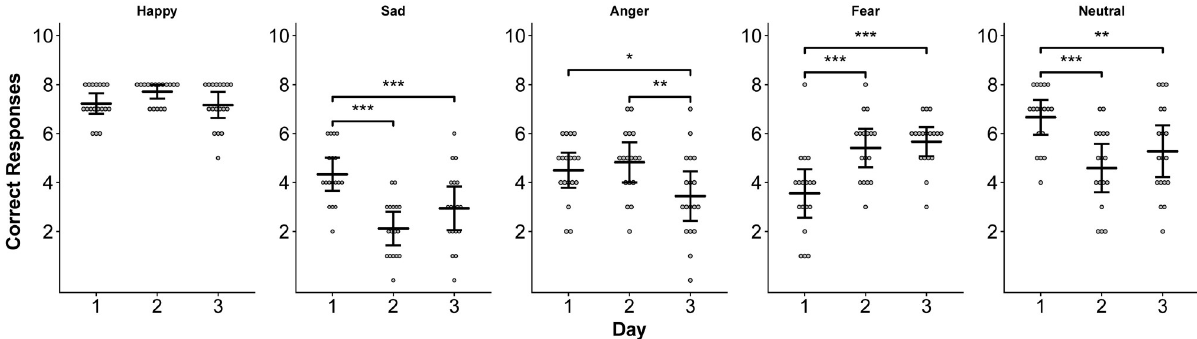
Fig 4. Altitude effects on emotion recognition. The total number of correctly identified expressions over three days at high altitude. Subjects were presented with happy, sad, angry, fearful, and neutral expressions. Means and 95% confidence intervals for each day are presented. Asterisks indicate significant differences across days at p < 0.05 ( � ), p < 0.01 ( �� ), and p < 0.001 ( ��� ).